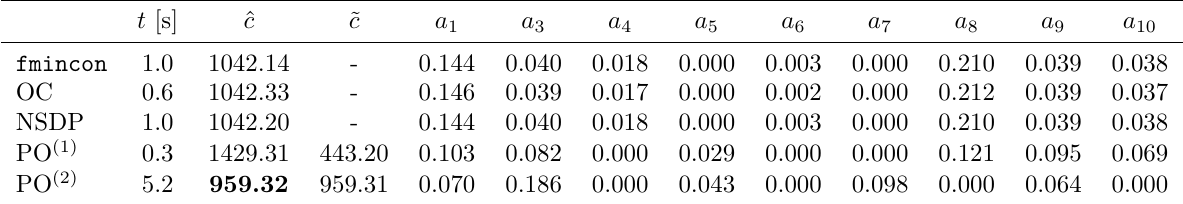
Table 2. Comparison of the four optimization approaches on the design of 10-beam structure. Bold text denotes proven global optimum. The cross-sectional area a 2 is zero in all test cases.